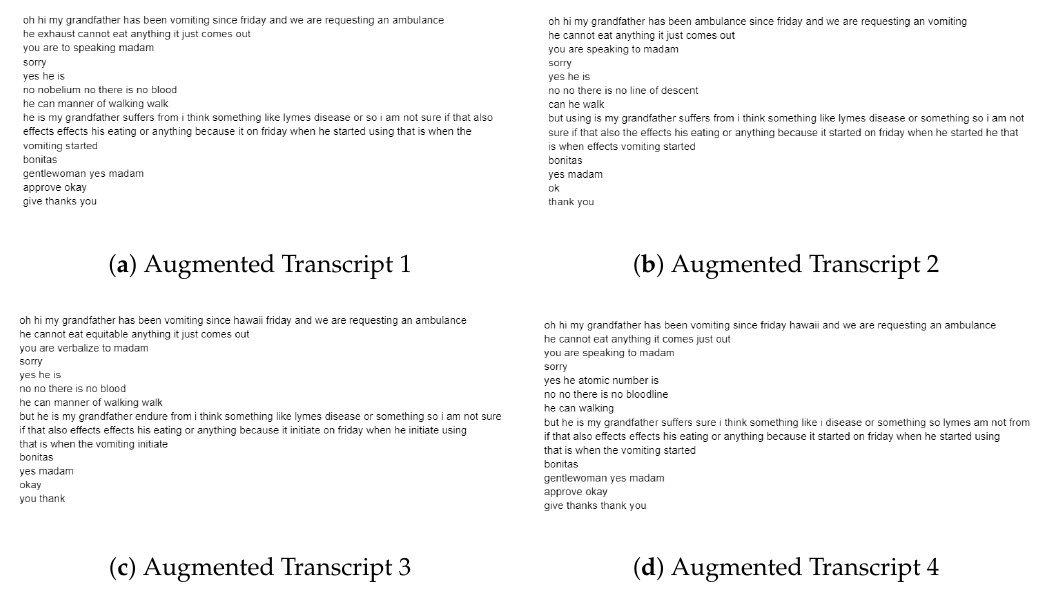
Figure 2. Examples of augmented transcripts.